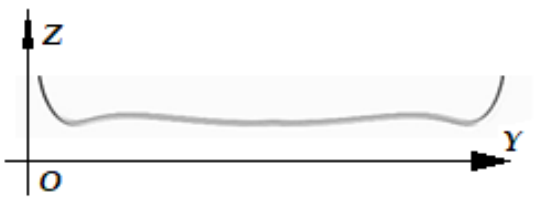
Figure 24. The curve drawn by the mechanism.